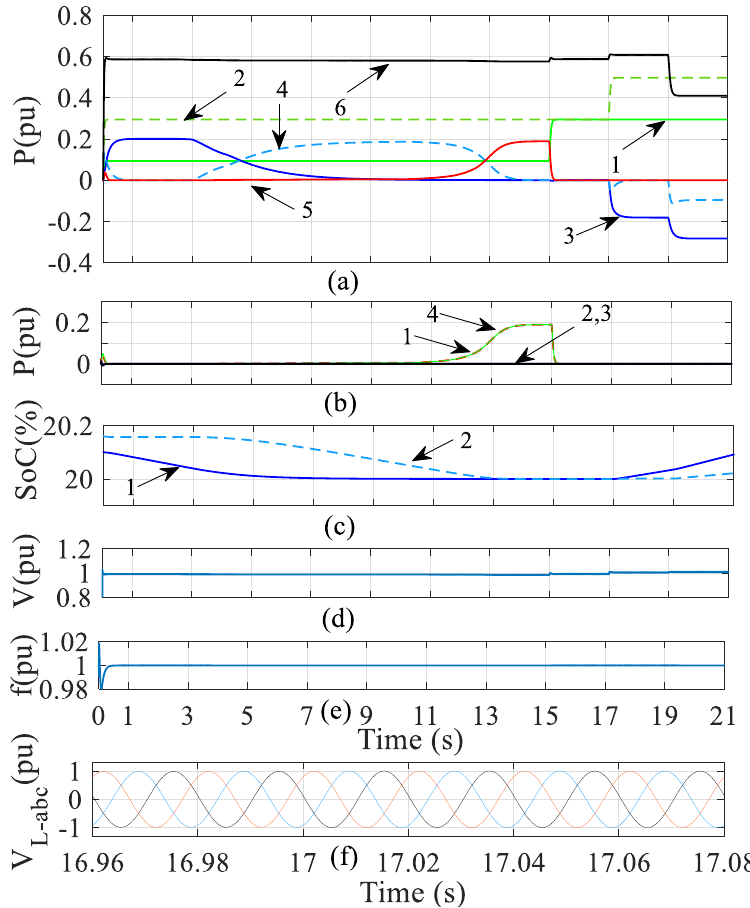
Figure 11. Priority between ES units. ( a ) Power (pu), 1 — P pv 1 ; 2 — P pv 2 ; 3 — P b 1 ; 4 — P b 2 ; 5 — P g ; 6 — P L . ( b ) Power from MGSCs (pu), 1 — P g 1 ; 2 — P g 2 ; 3 — P g 3 ; 4 — P g . ( c ) SoC (%), 1 — SoC 1 ; 2 — SoC 2 . ( d ) V L (pu). ( e ) Load frequency (pu). ( f ) Instantaneous 3-phase load voltage zoomed-in at sudden generation change ( t = 17 s) time (pu).